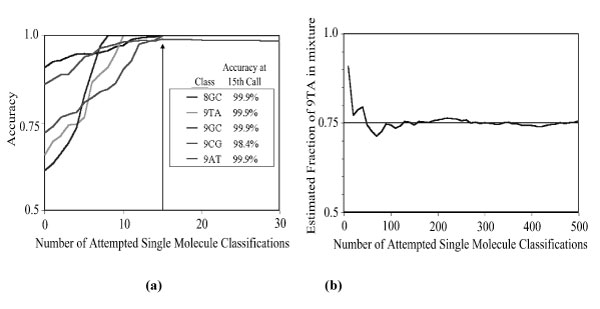
Panel (a) shows the single-species prediction accuracy as the number of signal classification attempts increases (allowing increase in the rejection threshold). Panel (b) shows the prediction accuracy on 3:1 mixture of 9TA to 9GC DNA hairpins (from [9]).